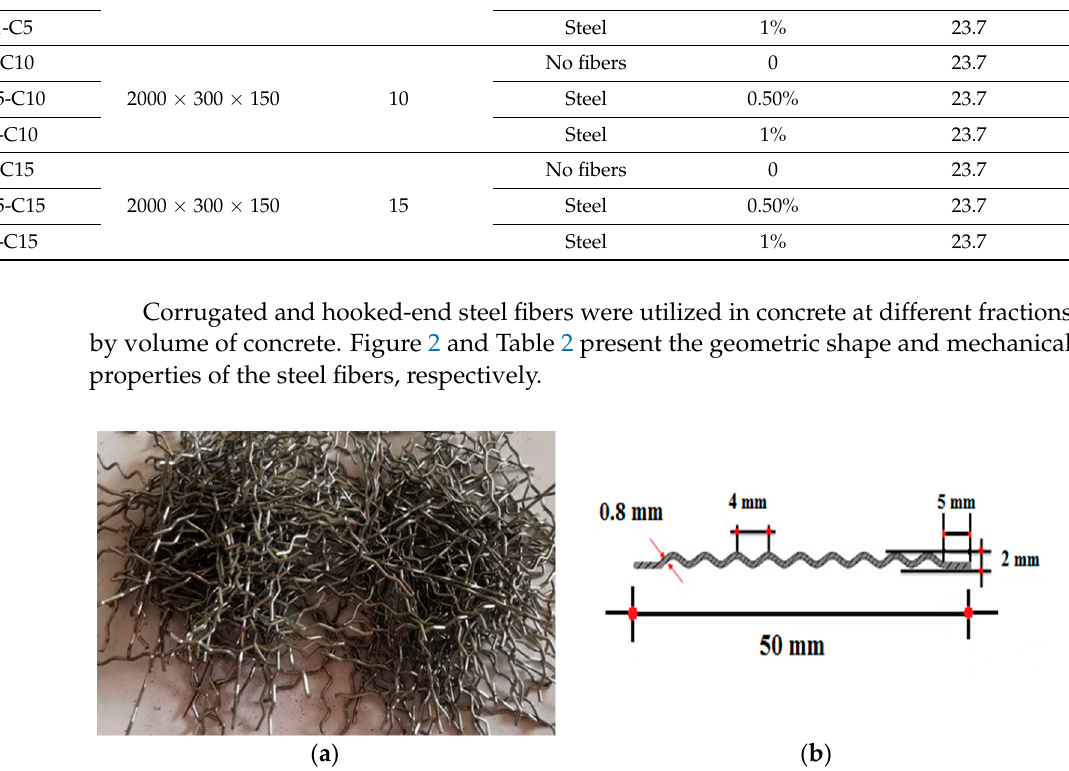
Table 3. Mechanical properties of prestressing wires.